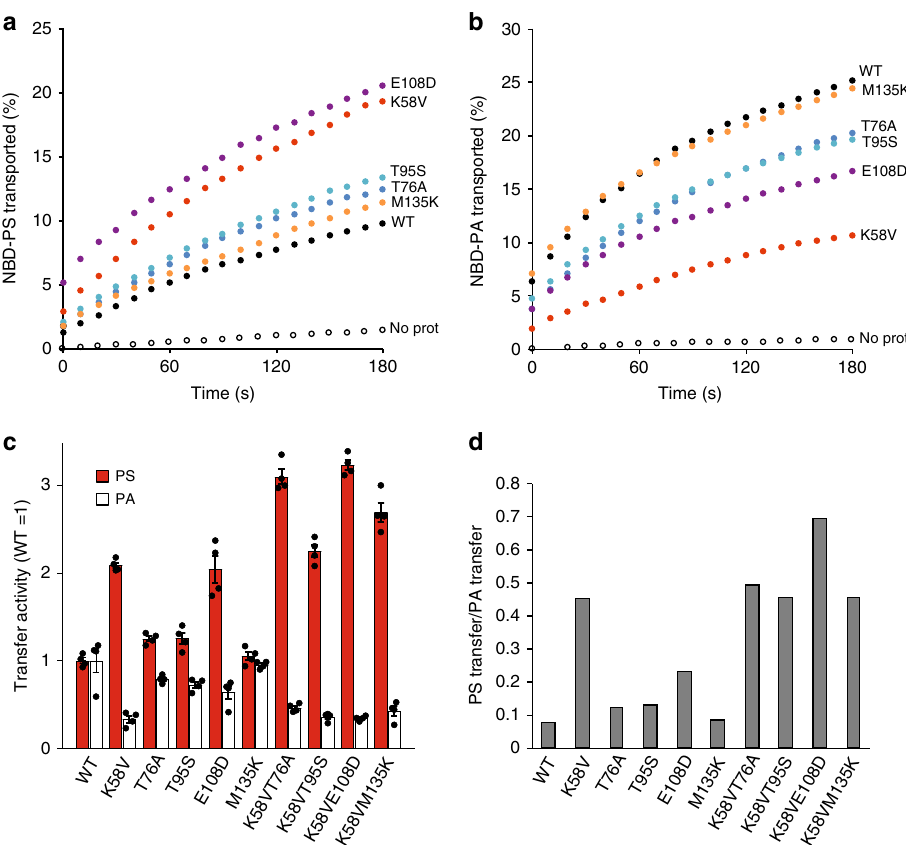
Fig. 3 Lipid transfer speci fi city of Ups1 mutants. a PS transfer of wildtype (WT) and mutant Ups1 – Mdm35 complexes in vitro. Recombinant protein complexes (50 nM) were incubated with donor liposomes (12.5 µ M) containing NBD-PS and Rhodamine-PE (PC/PE/CL/Lac-PE/NBD-PS/Rhodamine- PE = 50/33/5/5/5/2 mol%) and acceptor liposomes (50 µ M; PC/PE/CL/Lac-PE/PS = 50/35/5/5/5 mol%) at 20 °C and NBD fl uorescence was monitored. b PA transfer of wildtype (WT) and mutant Ups1 – Mdm35 complexes in vitro. Recombinant protein complex (12.5 nM) were incubated with donor liposomes containing NBD-PA and Rhodamine-PE (12.5 µ M; PC/PE/CL/Lac-PE/NBD-PA/Rhodamine-PE = 50/33/5/5/5/2 mol%) and acceptor liposomes (50 µ M; PC/PE/CL/Lac-PE/PA = 50/35/5/5/5 mol%) and NBD fl uorescence was monitored. c Relative PS (red) and PA (white) transfer activates of Ups1 variants. Data were normalised to the activities of WT. Error bars represent mean ± SEM, n = 4. d PS transfer activities of Ups1 variants relative to their PA transfer activities. See also Supplementary Fig.